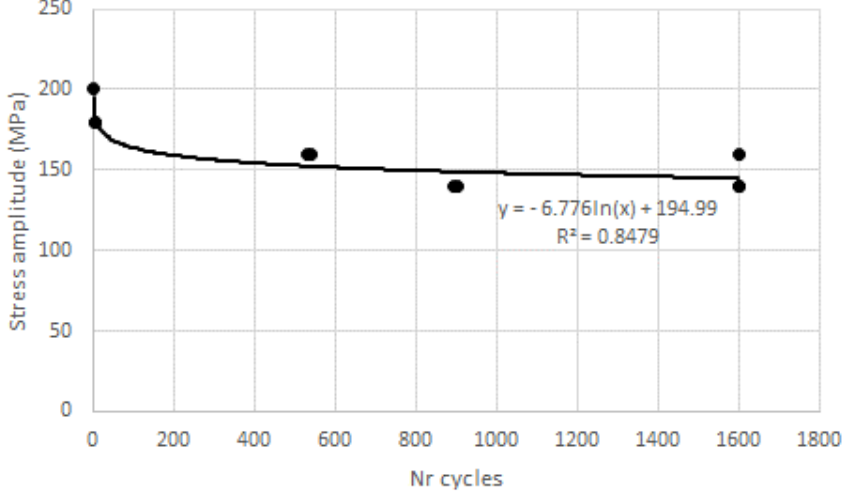
Figure 8. Stress amplitude vs. number of cycles for unidirectional plates.